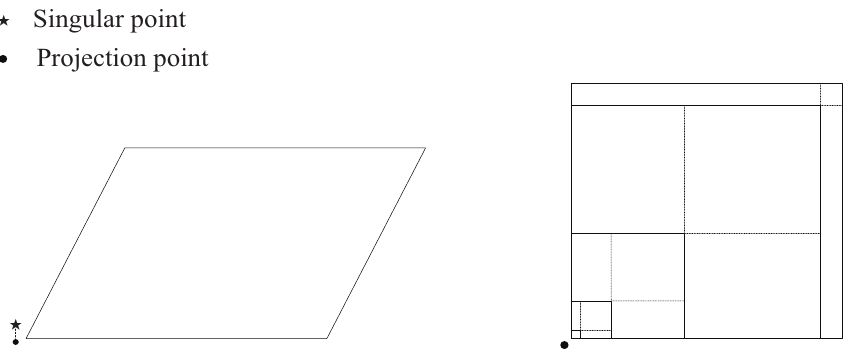
Figure 4. The partition method in Case III (left: location of the singular point z ∗ and projection point z . right: the nonuniform grid).